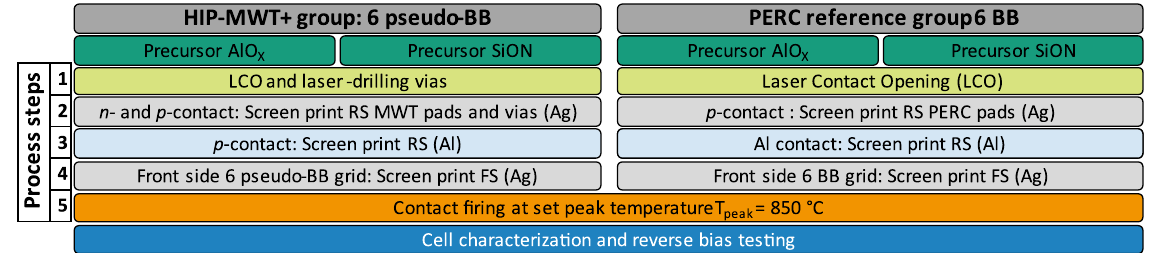
Fig. 3. Process steps for HIP-MWT +cells and PERC reference cells. The process steps for HIP-MWT+ cells (left) are also re fl ecting the process steps for the test structures use for the LIT characterization. Merely the LCO and rear side metallization layouts